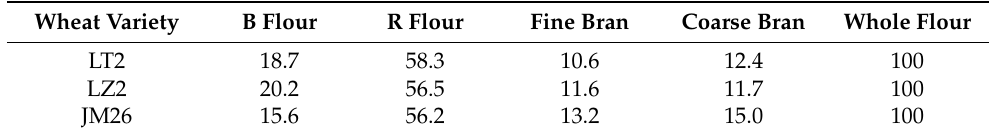
Table 1. Percentages of milling fractions (B flour, R flour, coarse bran, and fine bran) and whole flour of LT2, LZ2, and